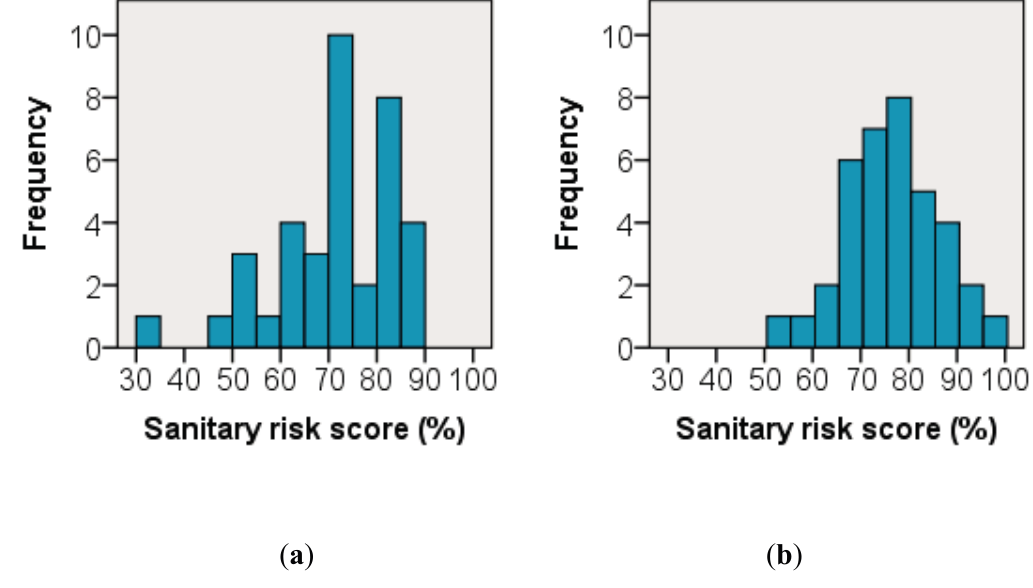
Figure 3. Histograms of sanitary risk scores calculated for paired wells (n = 37) in Manyatta A and Migosi during ( a ) the baseline survey (1999–2004) and; ( b ) the follow-up survey